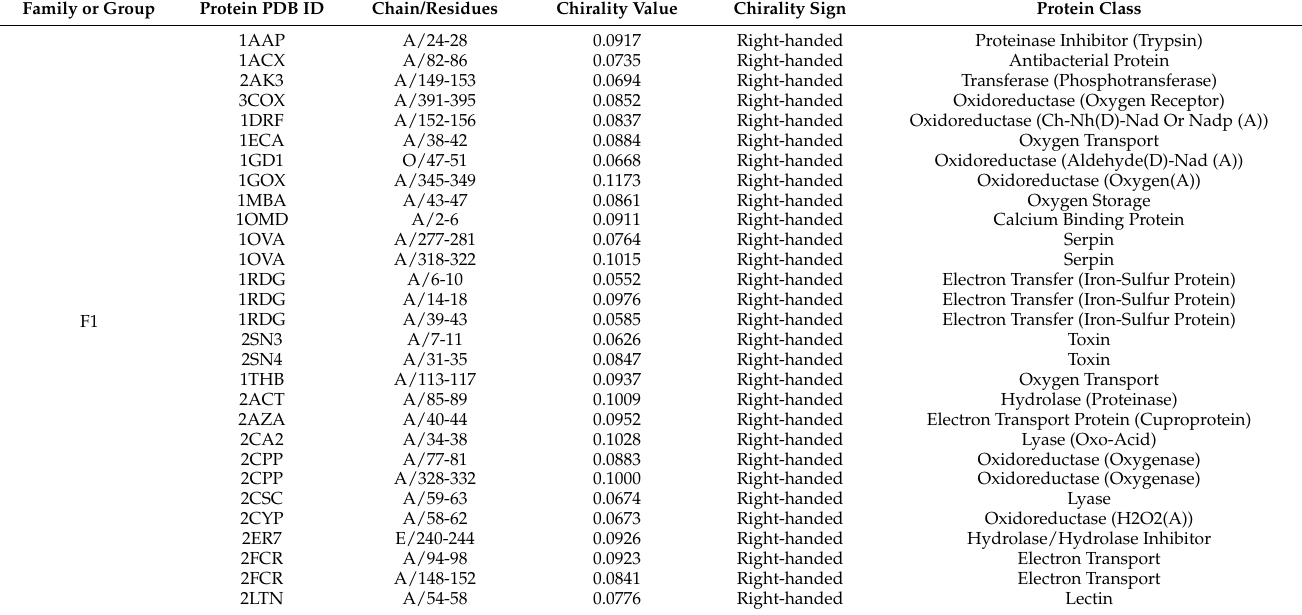
Table A2. The calculated parameters of α